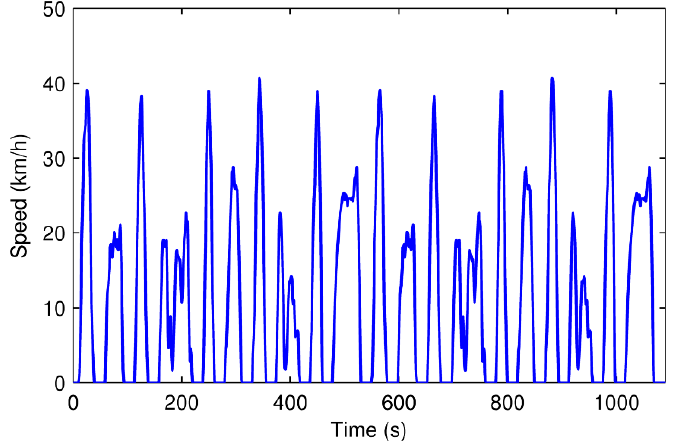
Figure 2. Speed profile of Manhattan driving